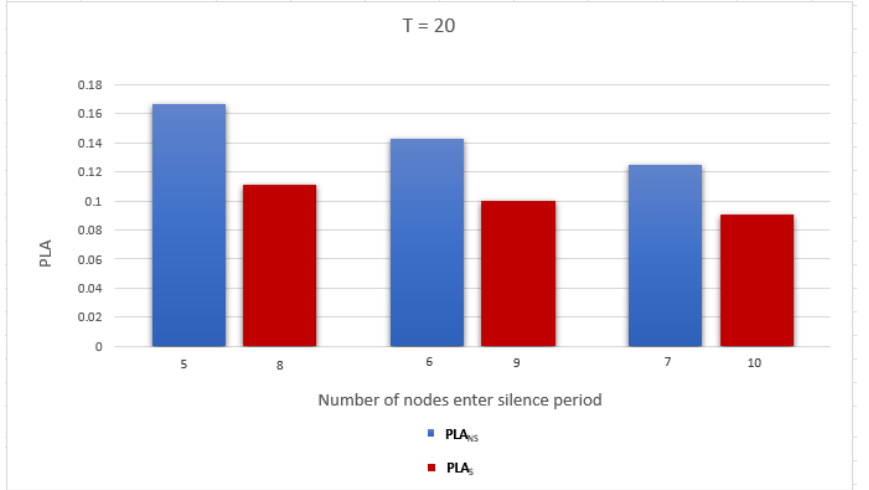
Figure 12. Probability of linkability (PLA) of the source node in a network with 20 nodes.